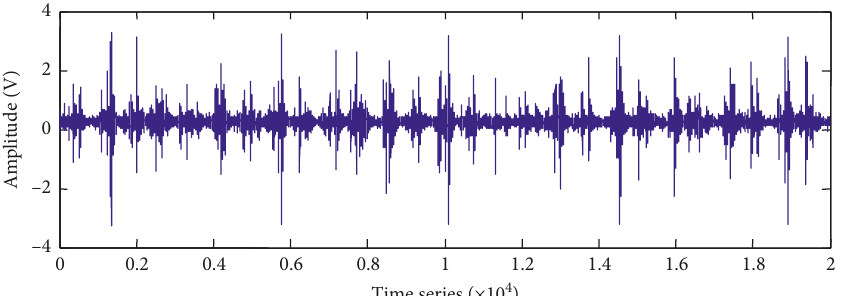
Figure 4: Original vibration signal.